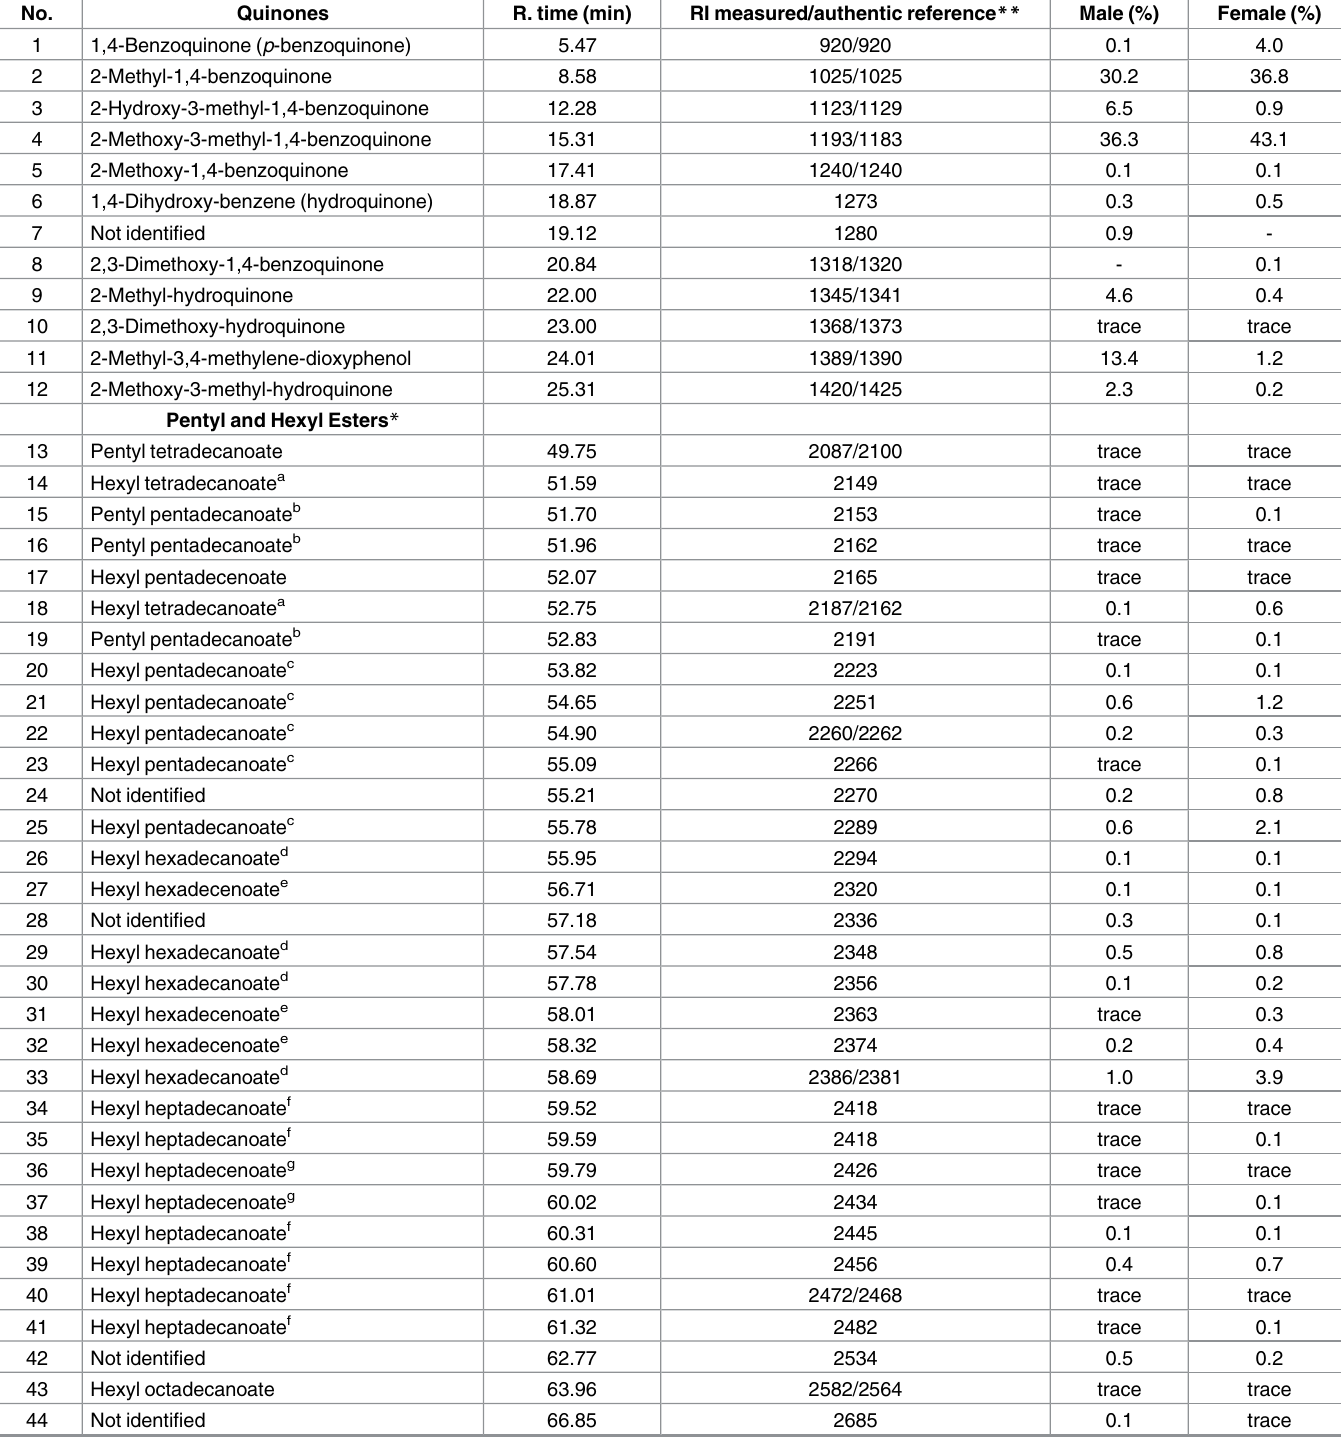
Table 1. Chemical composition of the defensive secretion in Pachyiulus hungaricus (Karsch,1881).